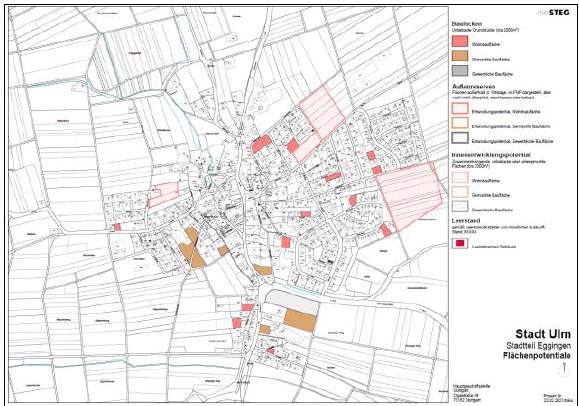
Figure 6 : Locations of the Potential Lands in Eggingen District, Source: die STEG